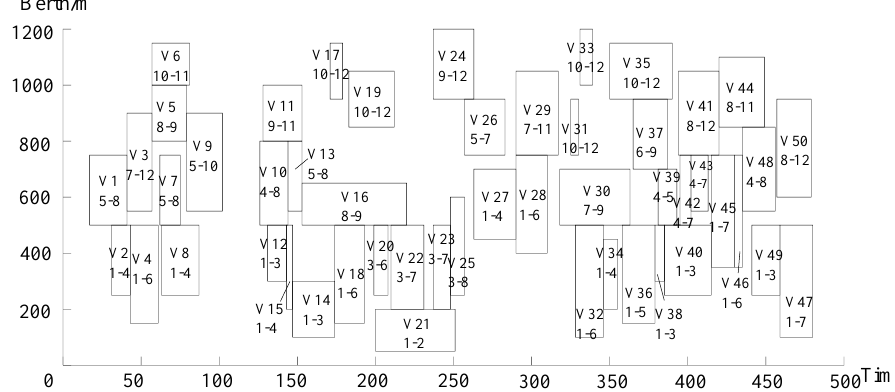
Figure 8. Best solution obtained by the LNS for instance i